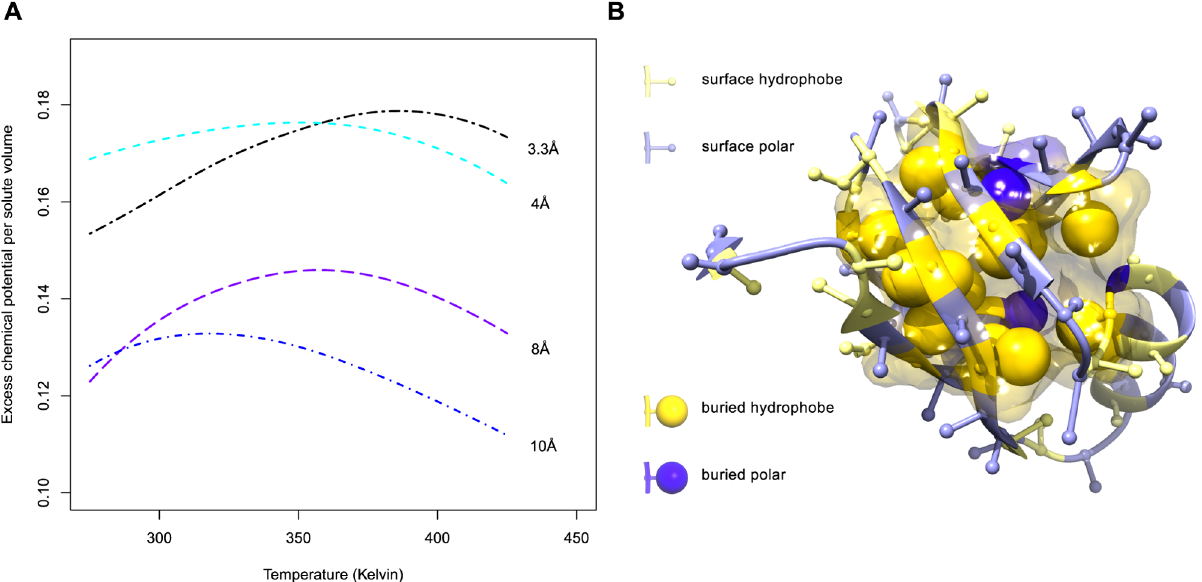
Fig 1. Length scale dependence of hydrophobic effect from calculations by Huang and Chandler [10] (A). The cost of making a cavity in the water with a radius of the given size against temperature is plotted. The position of the maximum depends on the size (radius) of the solute. Small solutes with a radius of 4 Å have a peak at around 70°C, whereas larger particles with a radius of 10 Å have a peak around 40°C. An example protein structure: PDB-ID: 2K5I (B). We estimate free energies of transfer from the hydrophobic core to the surface of the protein by comparing the number of hydrophobic amino acids on the surface (small yellow spheres), to the number of buried hydrophobics (large yellow spheres), to the number of polar amino acids on the surface (small blue spheres) and to the number of buried polar amino acids (large blue spheres).